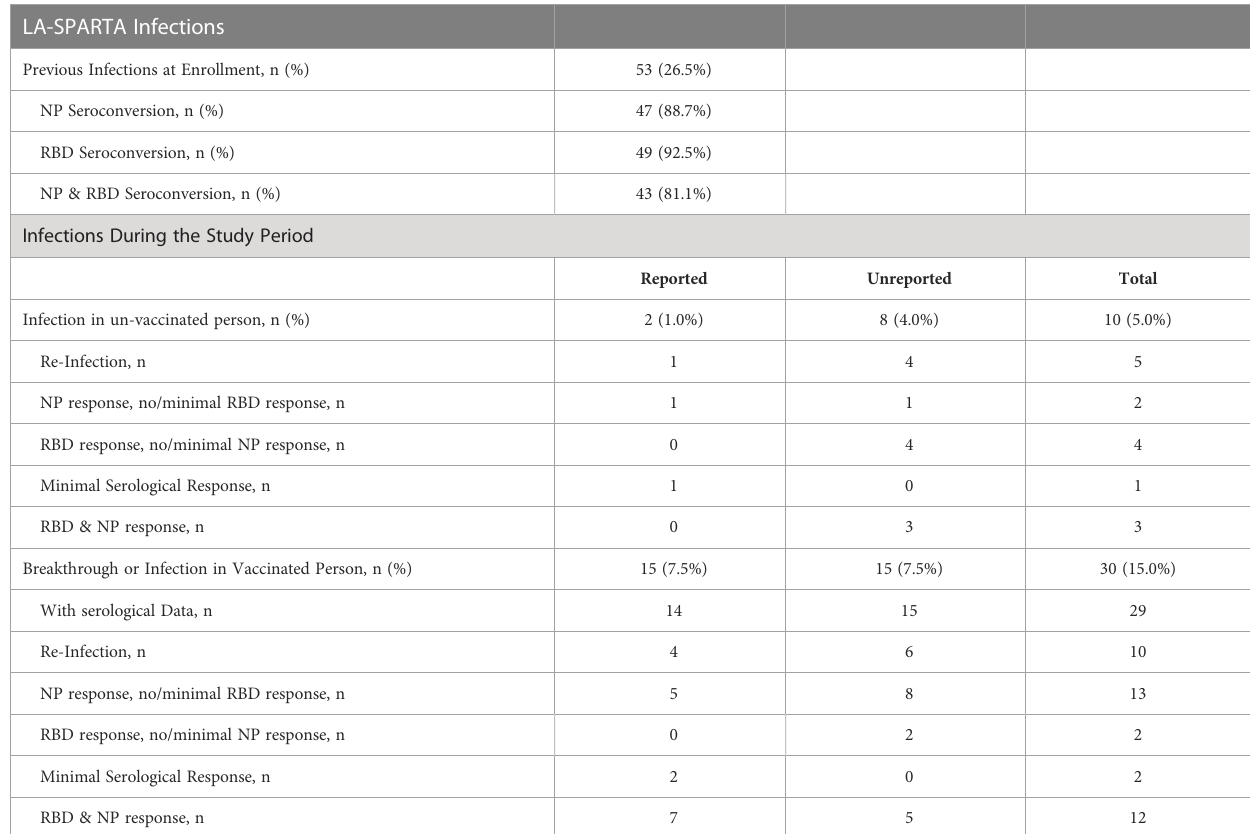
TABLE 3 Serological response to infection based on RBD and NP antibody